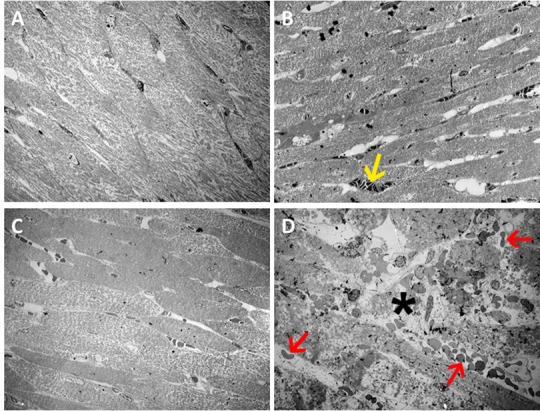
Overview of TEM Images.Transmission electron microscopy images, overview images, magnification 560x. A Images from control samples. B-D Images from infarct zone samples. B 30–0 group, C 90–0 group, D 30–60 group. Massive tissue damage is visible (asterisk), with extravasation of erythrocytes (red arrow), and intraluminal erythrocytes (yellow arrow). White bar represents 10 micrometer.